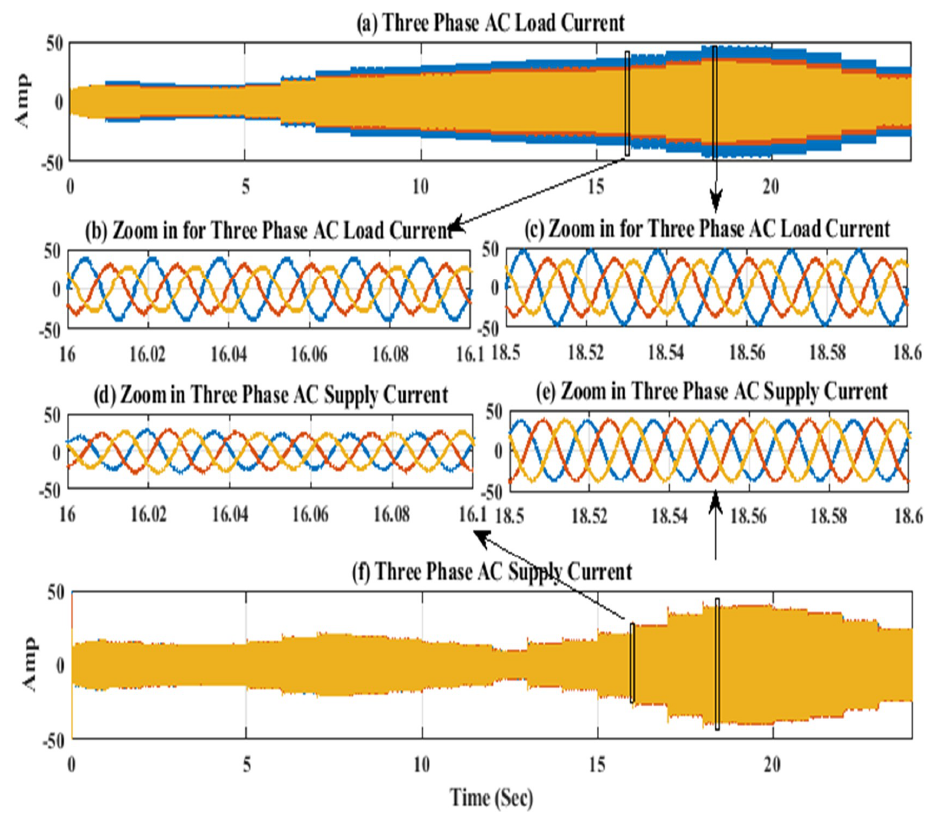
Figure 8. Simulation results: ( a ) alternating current (AC) load current, ( b ) zoom in for the AC load current between (16.0–16.1) s, ( c ) zoom in for AC load current between (18.5–18.6) s, ( d ) zoom in for AC supply current between (16.0–16.1) s, ( e ) zoom in for AC supply current between (18.5–18.6) s, and ( f ) AC supply current.